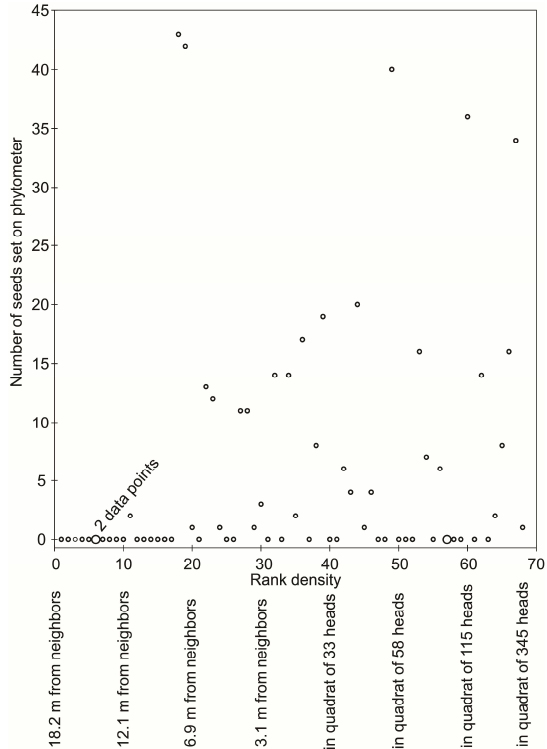
F IGURE 4. Seed production in 2009 scattered against rank density. Bubble size indicates number of overlapping data points. Phytometers placed the farthest from other flowering P. lyonii produced zero